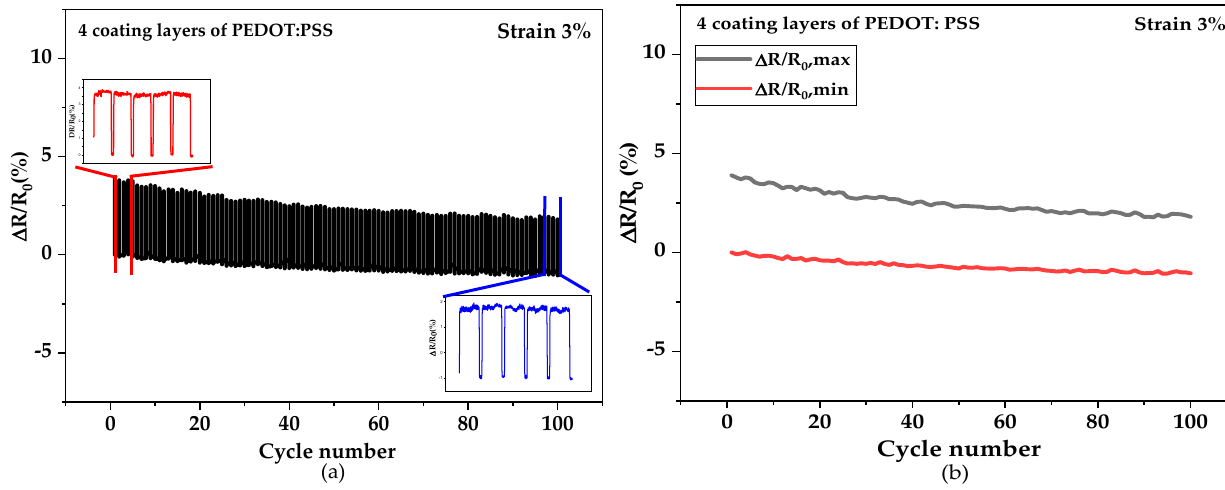
Figure 11. Multi-cycle elongation for the sensor yarns. ( a ) The ∆ R/R 0 of 100 stretching–releasing cycles with a maximum strain 3% at a slow rate of 200 mm · min − 1 for sensor yarns with four coated layers of PEDOT:PSS; ( b ) The ∆ R/R 0 at strain 3% up to 100 cycles for strain-sensor yarns with four coated layers of PEDOT:PSS.